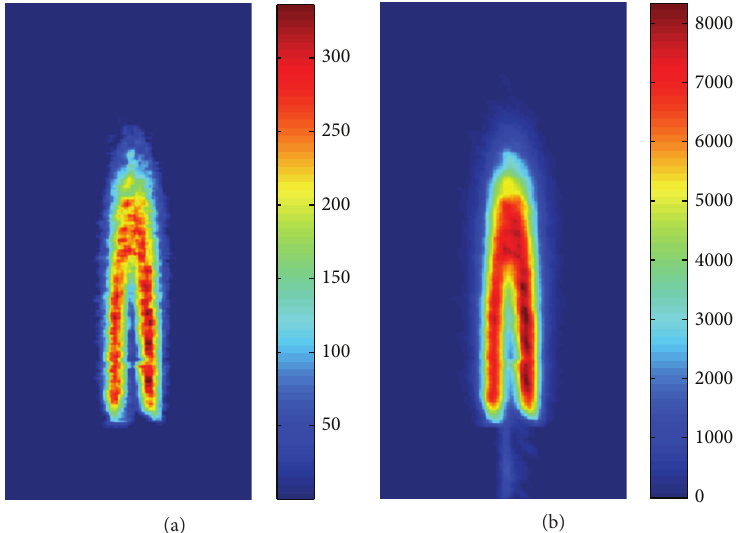
Figure 8: Comparison of the reconstructed result (a) and the side image (b) of the OH ∗ chemiluminescence.